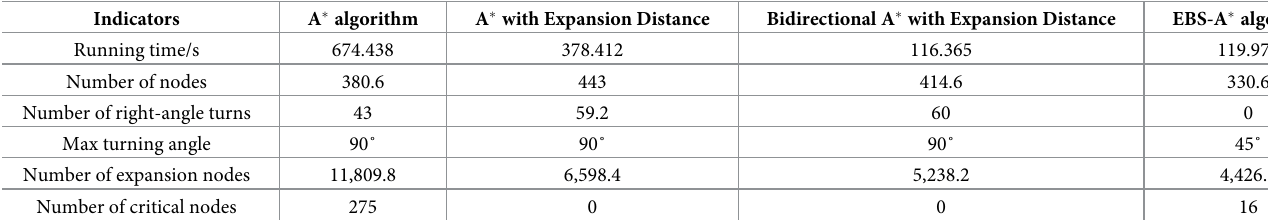
Table 8. Average simulation results of four algorithms on randomized 200 × 200 maps.